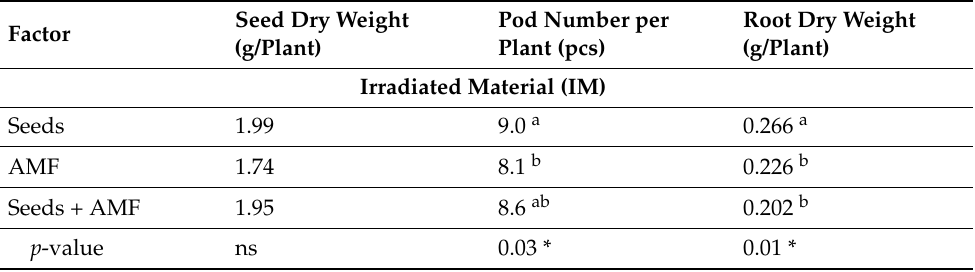
Table 1. Effect of irradiation stimulation on the seed dry weight, number of pods per plant, and root dry